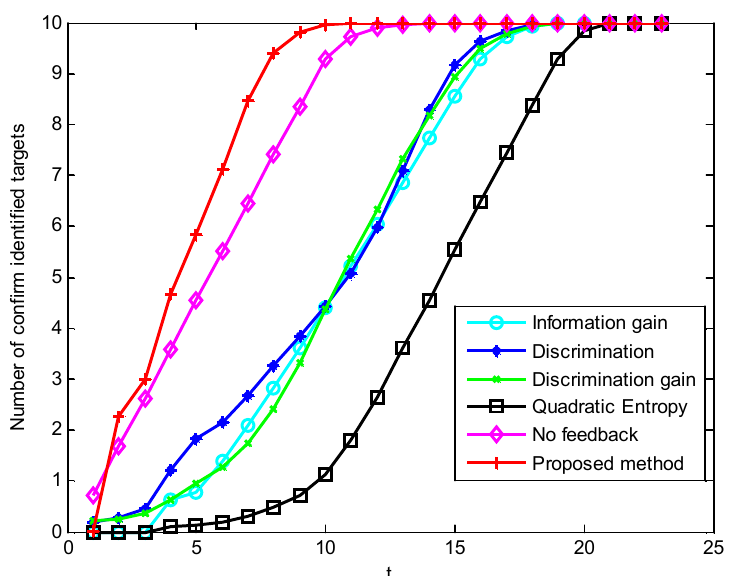
Figure 7. Sequence diagram of the number of confirmed targets in scenario 5 under condition 1.